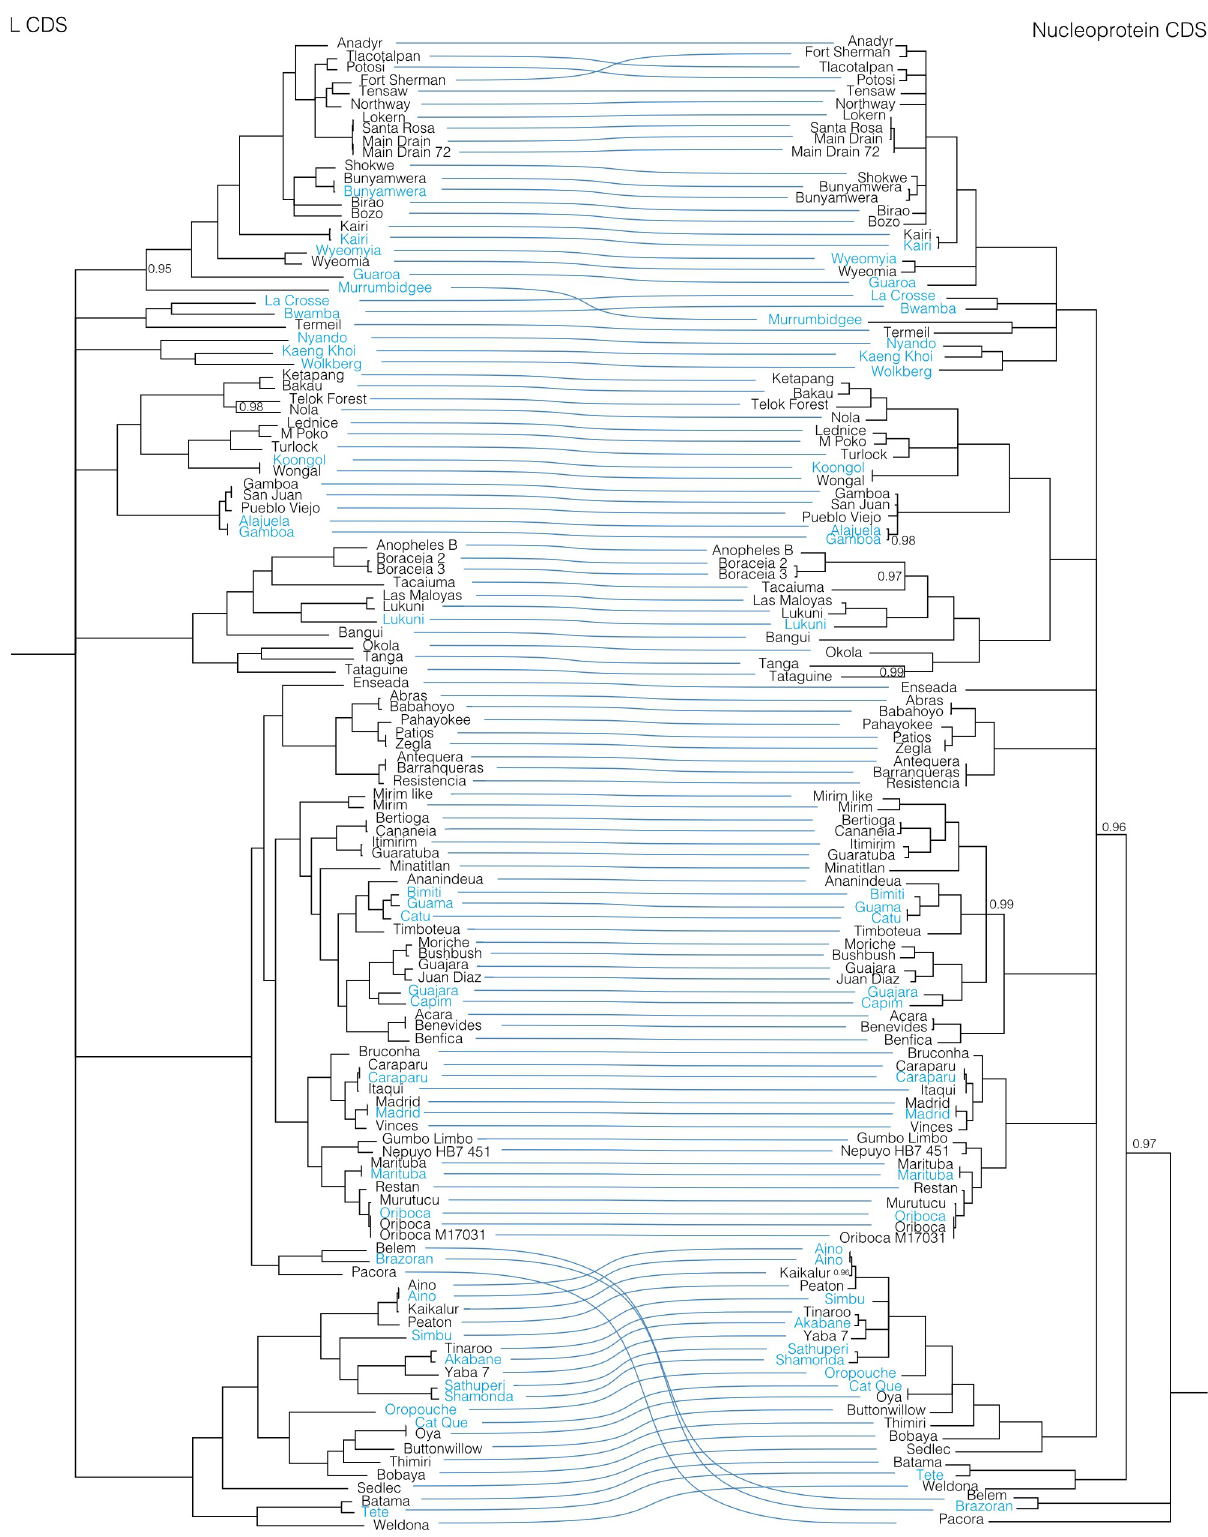
Fig 7. Co-phylogenies of Orthobunyavirus L and S segment trees. Branches with support values < 0.95 were converted to polytomies. All other branch support values were 1 unless indicated. Trees were rooted with outgroups as in Figs 2–4.